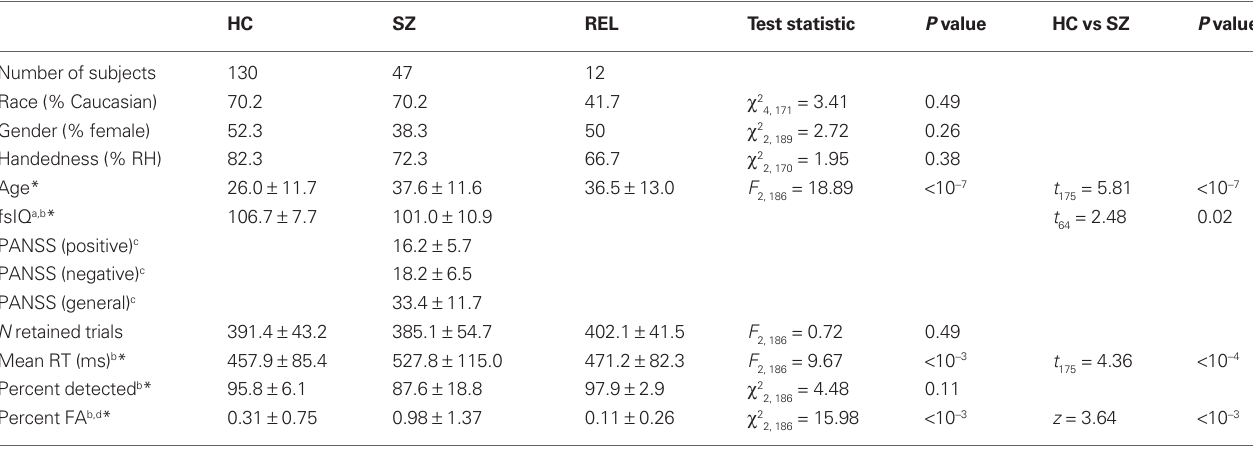
Table 1 | Demographic, clinical, and behavioral data for subject